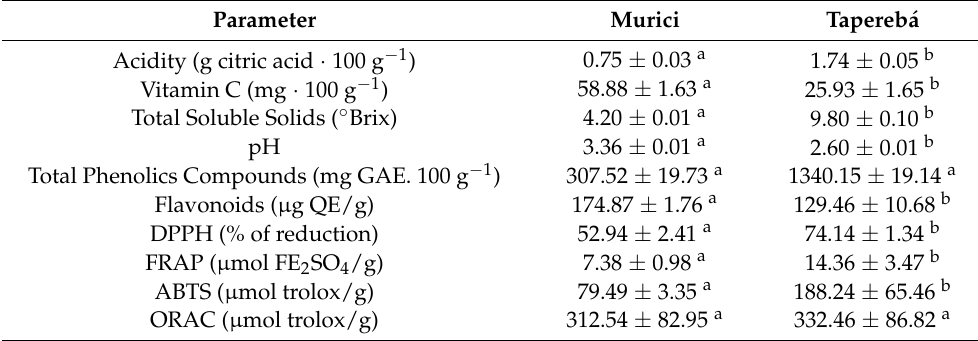
Table 1. Physicochemical characterization, bioactive compounds, and antioxidant activity of murici and tapereb á